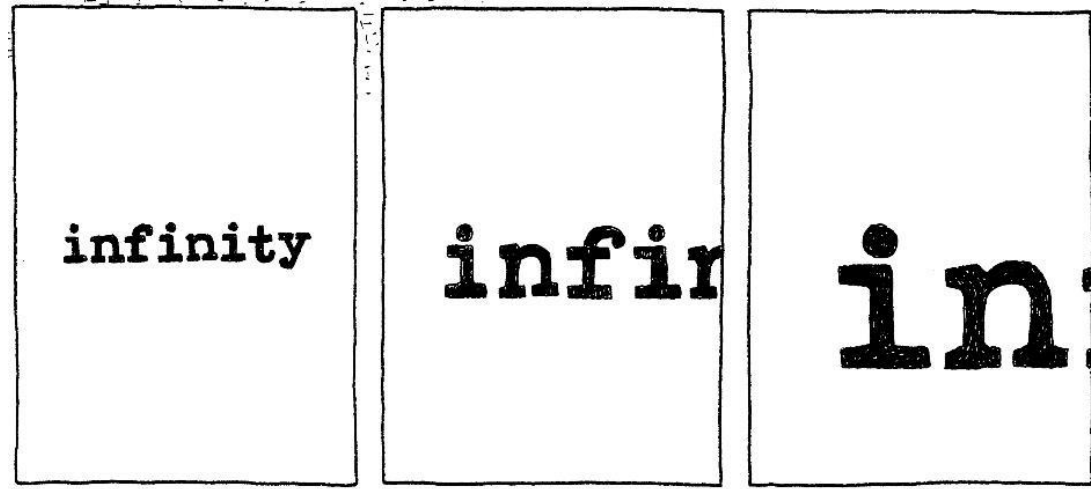
Figure 6. From Cotter, Nod Away , 23. Copyright, 2016, Joshua W